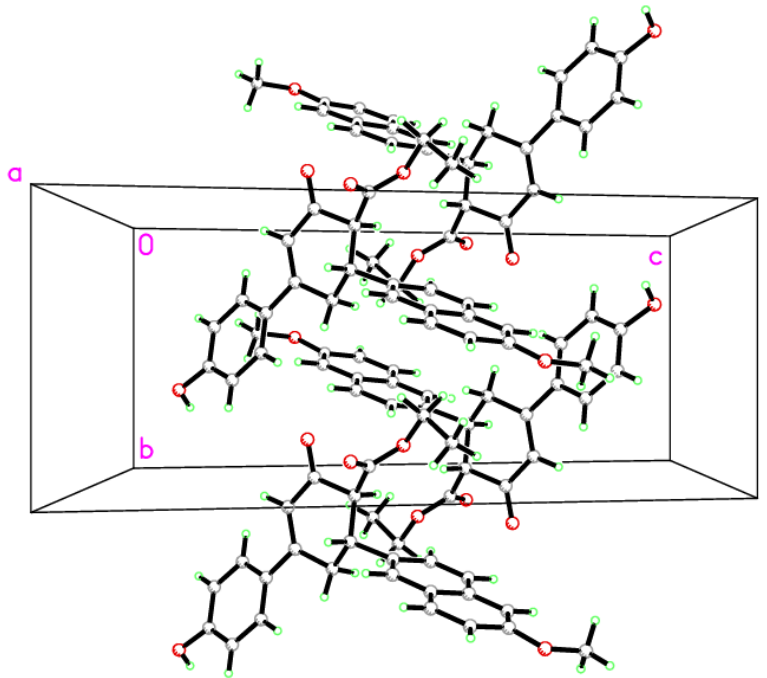
Table 3. Hydrogen bonds for ( II ) C